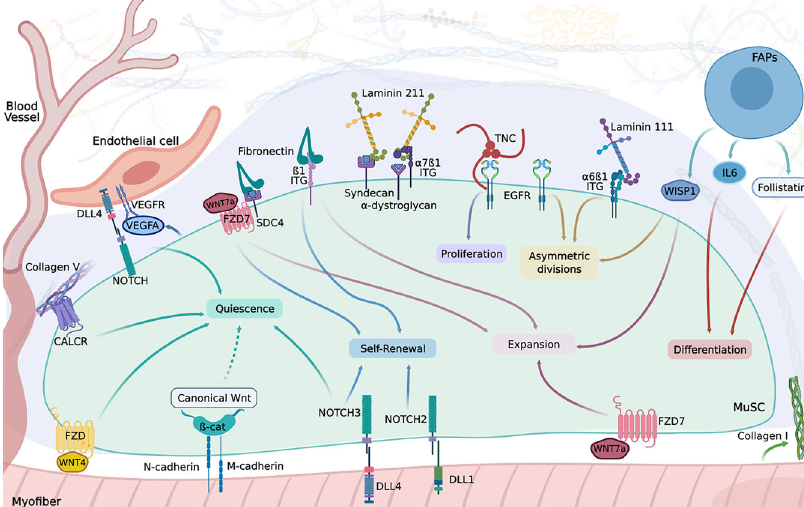
Fig. 3 A schematic representation showing how MuSC interact with their microenvironment. MuSC are in direct contact with myo fi bers. These multinucleated cells secrete ECM proteins (as collagen-I) and soluble factors, including WNT4 and WNT7a, perceived through frizzled (FZD) receptors in the MuSC. As represented in this fi gure, MuSC directly interact with myo fi bers through Notch receptors and Dll ligands, and the cadherin-based adhesive junctions M- and N-cadherins. These adhesive junctions regulate MuSC quiescence through Canonical-Wnt (dotted arrow). However, ß-catenin activity has also been involved in the stimulation of MuSC differentiation 235 (not shown in the fi gure). On the opposite side, MuSC are exposed to multiple ECM proteins in the basal lamina and their microenvironment. MuSC respond to ECM proteins through interaction with integrins (ITG), Calcitonin (CALCR), syndecans (including syndecan-4 (SDC4)), α -dystroglycan, and EGF receptors. These stem cells are able to interact with endothelial cells via Vegf and Notch signaling. MuSC fate is also regulated by signals emitted by FAPs (WISP1, IL6, and